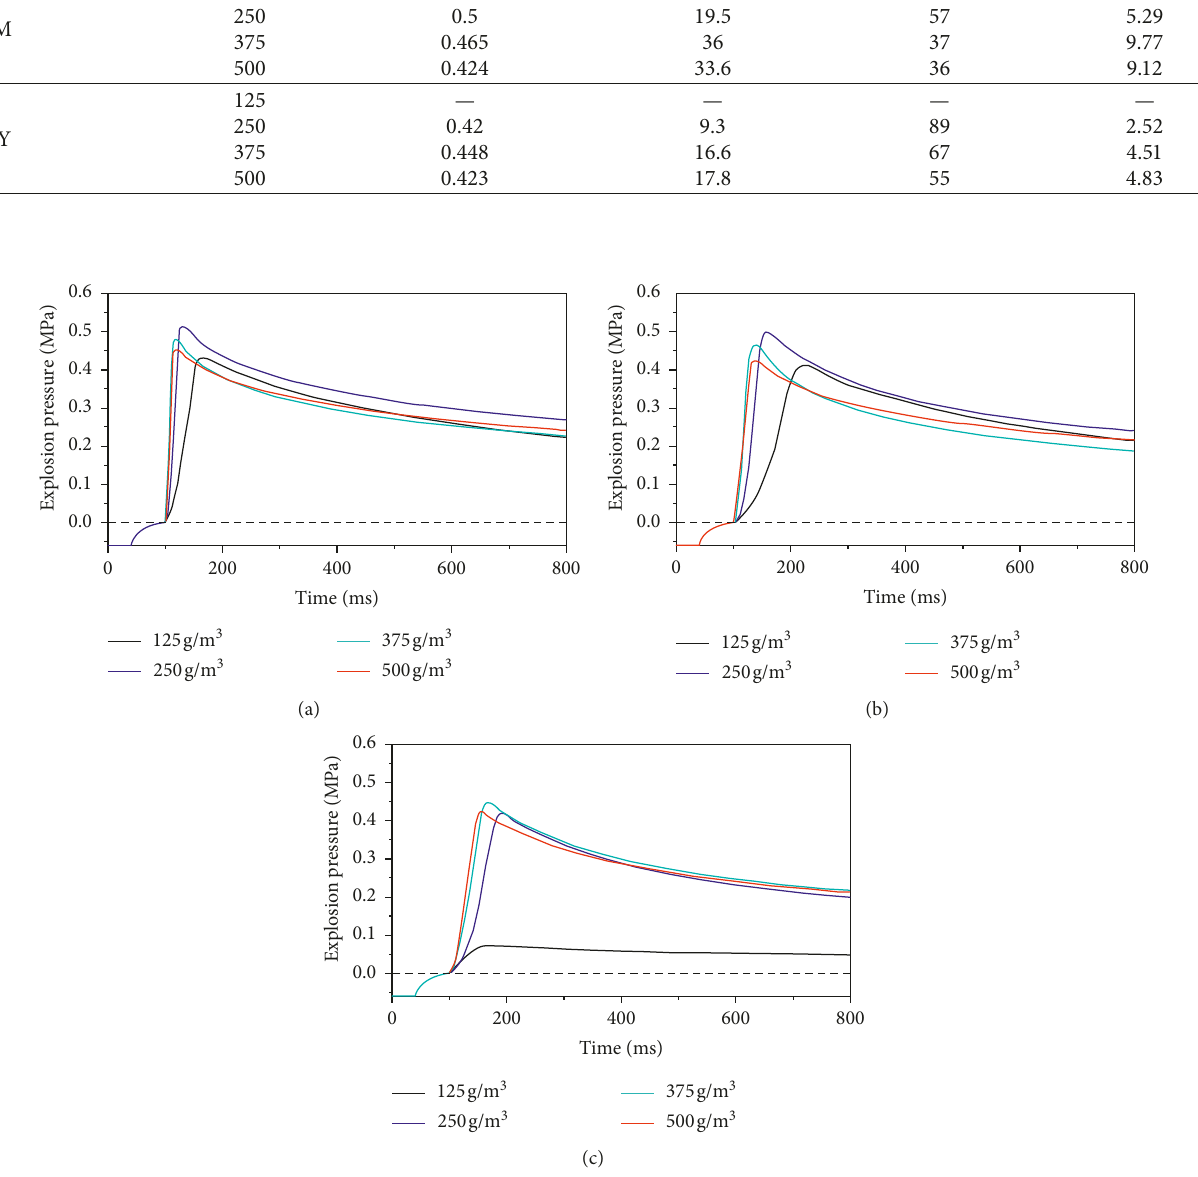
Figure 6: Explosion pressure time history of the three coal dust samples under different concentrations: (a) HM; (b) QM; (c)